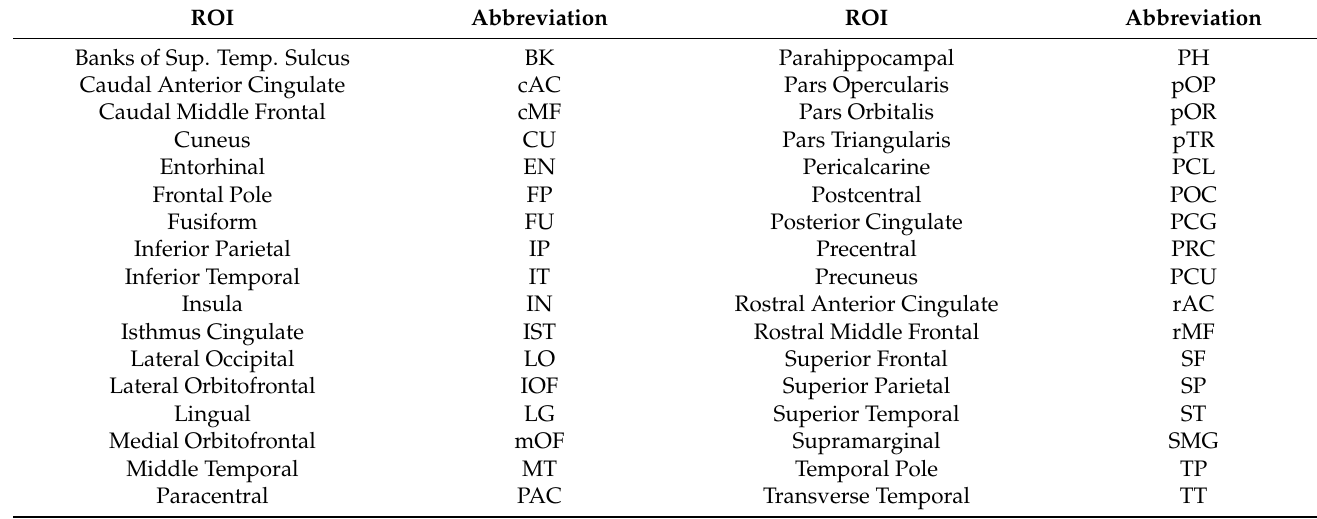
Table 1. The68ROIsdefinedbytheDesikan–KillianyAtlasprovidedintheBrainstormsoftwareandthecorrespondingabbreviation. ROI Abbreviation ROI Abbreviation Banks of Sup. Temp.